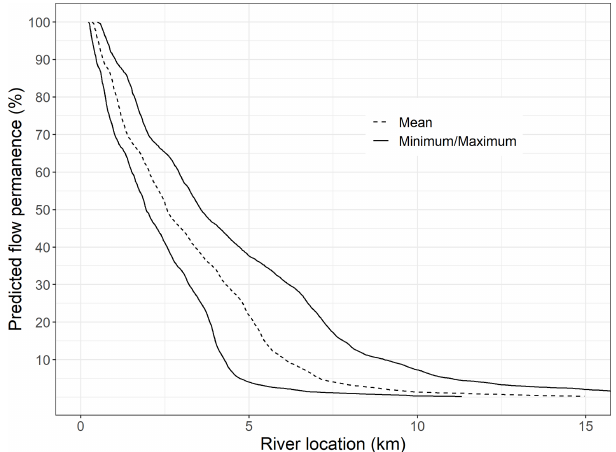
Figure 16. Longitudinal variation in flow permanence (proportion of the year with flowing water) downstream of our gauging station (Scotts Road = 0km) predicted using the random forest model en-